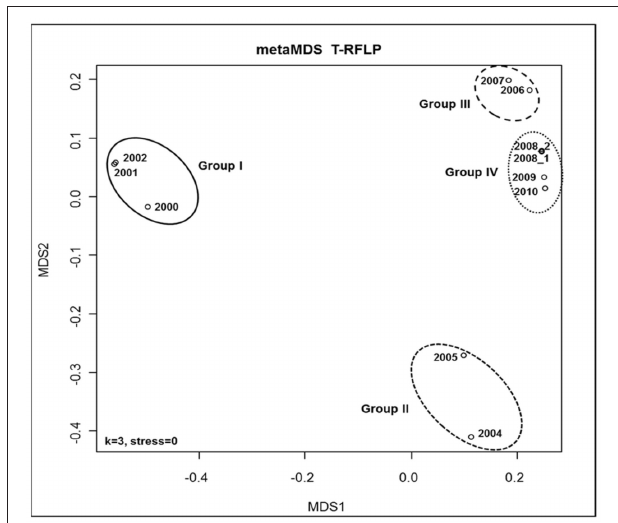
FIGURE 3 | Multidimensional scaling plot (MDS-plot) to illustrate differences between the 18S T-RFLP patterns of the different protist communities in the sediment traps. The MDS-plot is based on the calculation of Jaccard indices for the data set derived from amplification of a 18S PCR fragment and subsequent digestion with the restriction enzyme HaeIII.